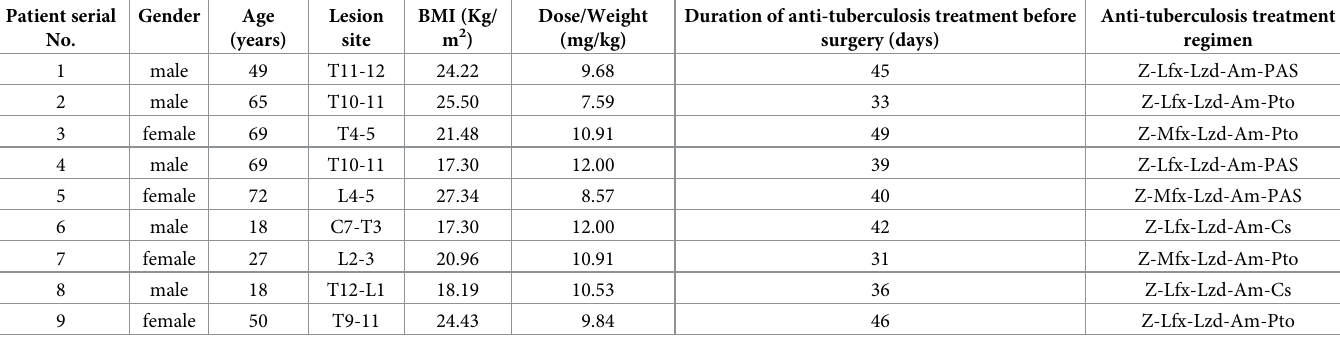
Table 1. Clinical characteristics of 9 studied